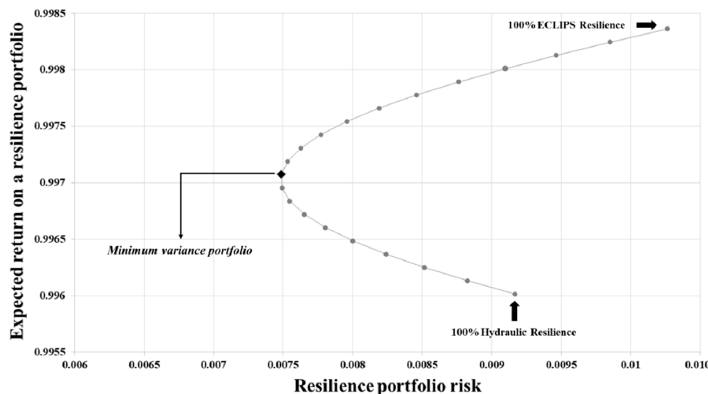
Figure 6. Efficient frontier between hydraulic resilience and ECLIPS resilience.